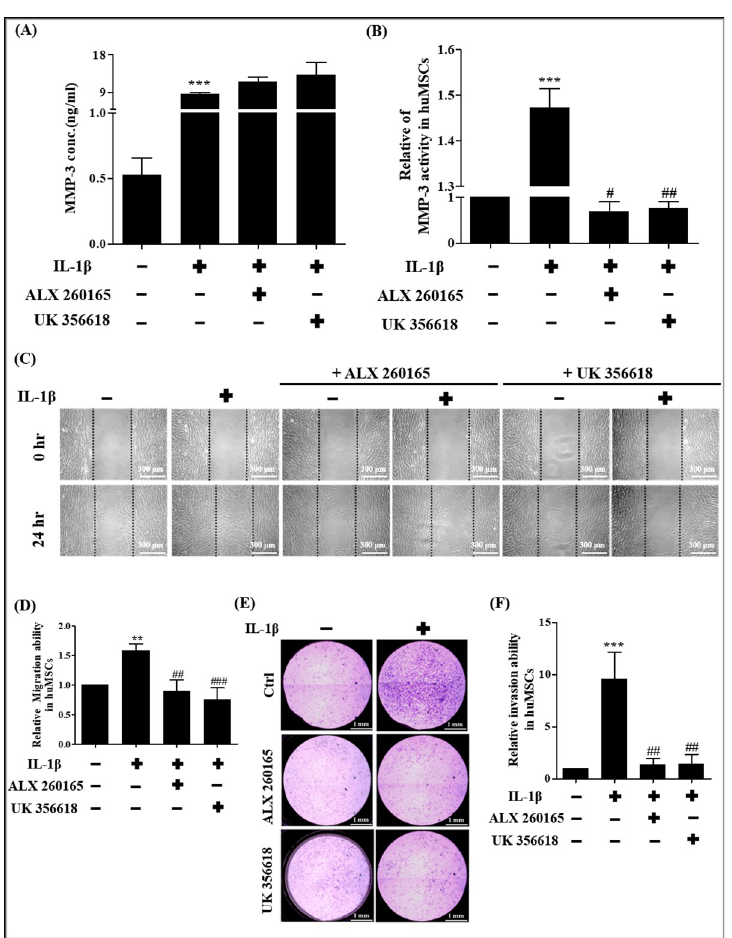
Fig 3. Effects of MMP-3 inhibitor in hUCMSCs on MMP-3 secretion and MMP3 activity, cell migration and invasion. (A) MMP-3 protein expression measured by ELISA. hUCMSCs treated with ALX 260165 and UK 356618 at concentration of 20 μ M. (B) MMP-3 activity was measured by Fluorogenic peptide Assays. hUCMSCs treated with ALX 260165 and UK 356618 at concentration of 20 μ M. (C) Cell wound healing assay. Cultures were treated with MMP-3 inhibitors ALX 260165, UK 356618 at concentrations of 20 μ M, 20 nM, respectively as indicated. Scale bars = 300 μ m. (D) Quantitative graph showing the migration ability of stem cells into the wound area at 24 hours. (E) Cell invasion assay, cultures were treated with MMP-3 inhibitors ALX 260165, UK 356618 at concentrations of 20 μ M, 20 nM, respectively as indicated. Scale bars = 1 mm. (F) Graph indicates the invasion ability of stem cells. Data are shown as the mean ± SD (n = 3, �� P < 0.01, ��� P < 0.005, versus control cells, #p < 0.05, ##p < 0.01, ###p < 0.005 versus IL-1 β treated